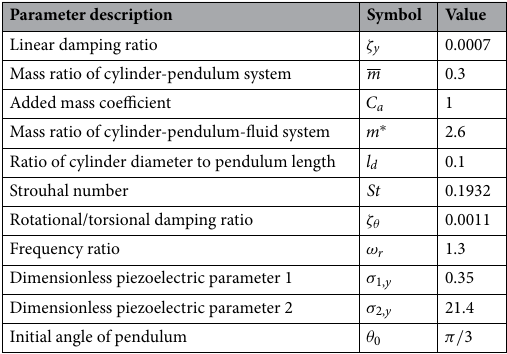
Table 1. Non-dimensional parameters for the NRGP-PZH-VIV